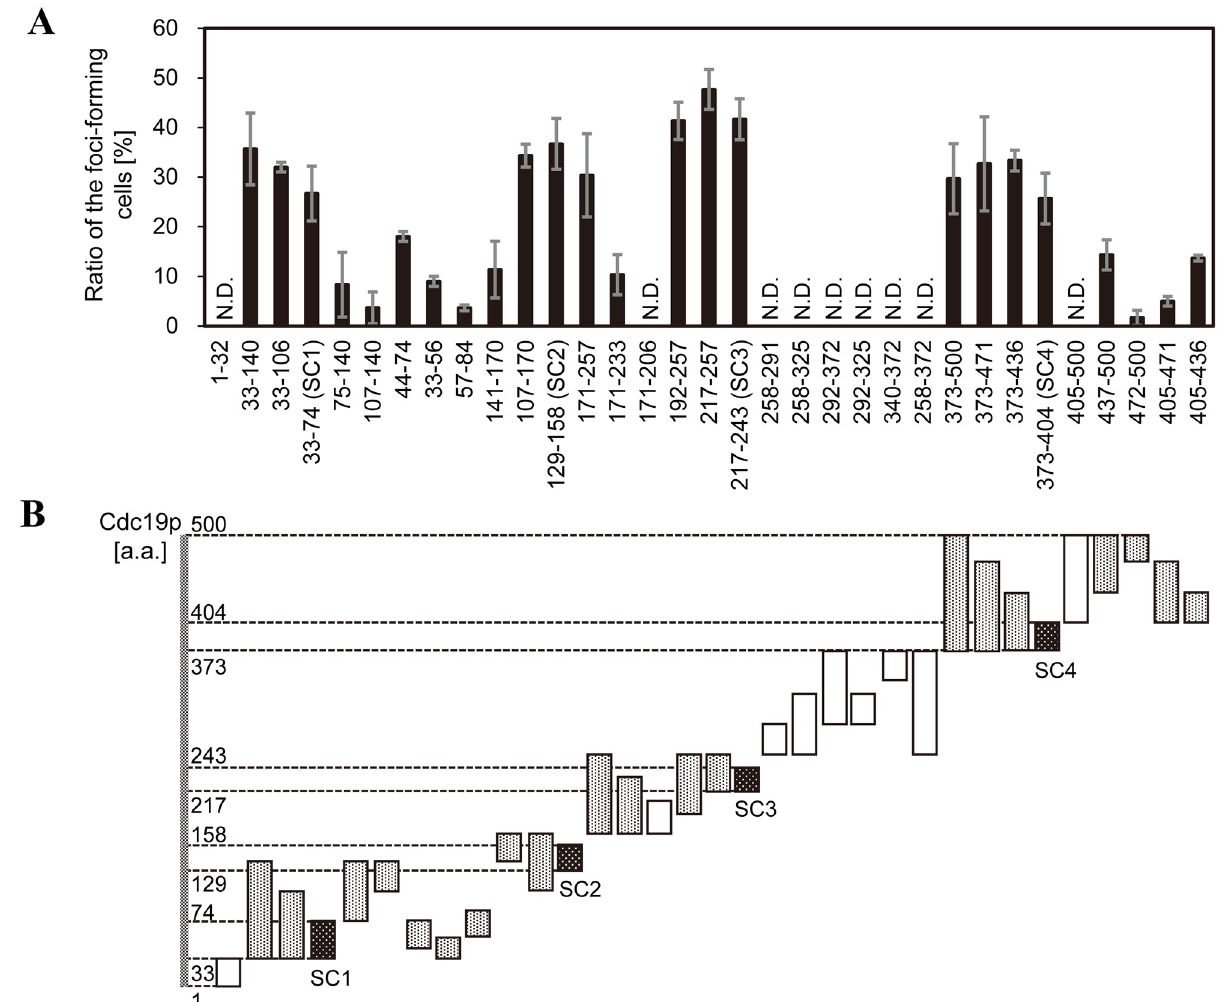
Fig 1. Foci formation by fragmented pyruvate kinase in S . cerevisiae . A: The ratio of foci formation for each fragment conjugated with EGFP and overexpressed in S . cerevisiae BY4741 wild type strain under normoxic condition. X axis shows the fragments of Cdc19p and the fragments correspond to the location shown in B. n = 3. Error bars show standard deviation. B: Overview of fragmented peptides. Numbers on the left indicate the amino acid residues of Cdc19p. White bars represent Cdc19p fragments fused with FusionRed that did not show foci, gray bars represent Cdc19p fragments that showed foci, and black dotted bars represent Cdc19p fragments with relatively high foci-forming ratios, namely SC1, SC2, SC3, and SC4. Dotted lines connect the bars to the numbers on the left to indicate the location of the fragments within Cdc19p. (scENO) [3], N-terminal region of FUS (FUSN), a representative IDR [26], and the amyloid- forming region of a yeast prion protein, Sup35p [27] (produced by plasmids p426- CUP1 p- SC2-Adh1p-FusionRed, p426- CUP1 p-SC3-Adh1p-FusionRed, p426- CUP1 p-scENO-Adh1p- FusionRed, p426- CUP1 p-FUSN-Adh1p-FusionRed, and p426- CUP1 p-SUP35-Adh1p- FusionRed, respectively). No foci were observed when the expression of red fluorescent pro- tein (FusionRed produced by plasmid p426- CUP1 p-FusionRed) or the fusion protein of FusionRed and Adh1p (Adh1p-FusionRed produced by plasmid p426- CUP1 p-Adh1p- FusionRed) were induced with up to 100 μ M CuSO (Fig 3C and S2 Fig in S1 File). However, 4 foci were observed when SC2, SC3, scENO, FUSN, or Sup35p were fused with Adh1p- FusionRed (Fig 3B). The co-localization of each peptide or protein fragment with META body